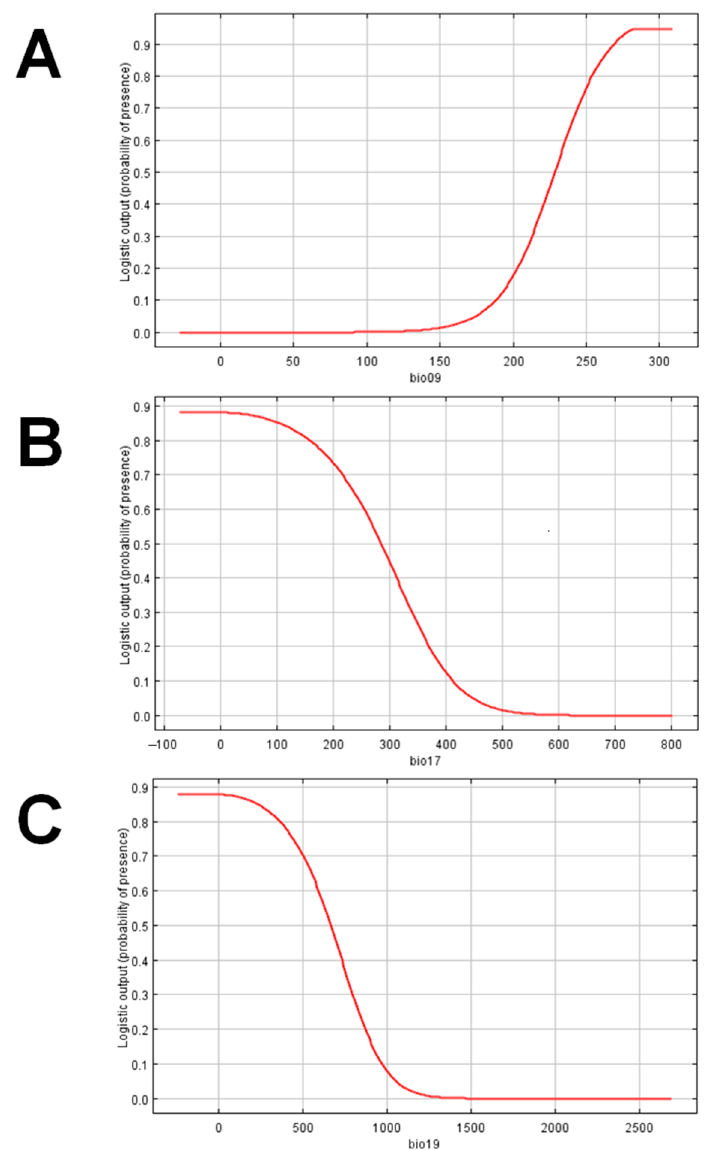
Figure 2. Response (probability of presence) of Comperiella calauanica to selected bioclimatic varia- bles: ( A ) mean temperature of the driest quarter; ( B ) precipitation of the driest quarter; and ( C ) precipitation of the coldest quarter.